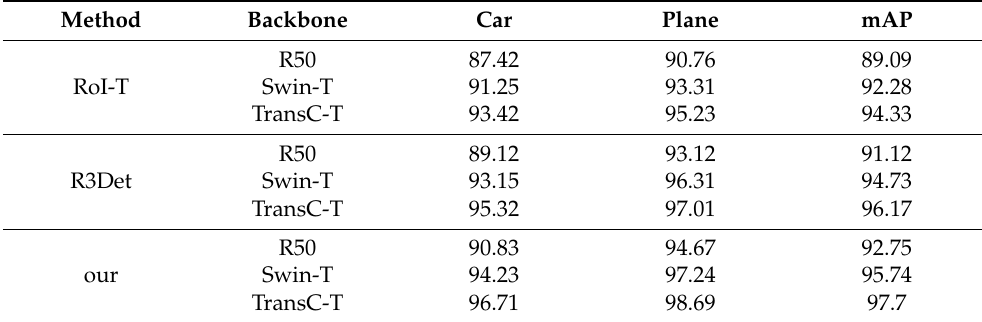
Table 2. Comparison of the results of RoI-transformer, R3Det, and our methods on UCAS-AOD data set based on three backbone